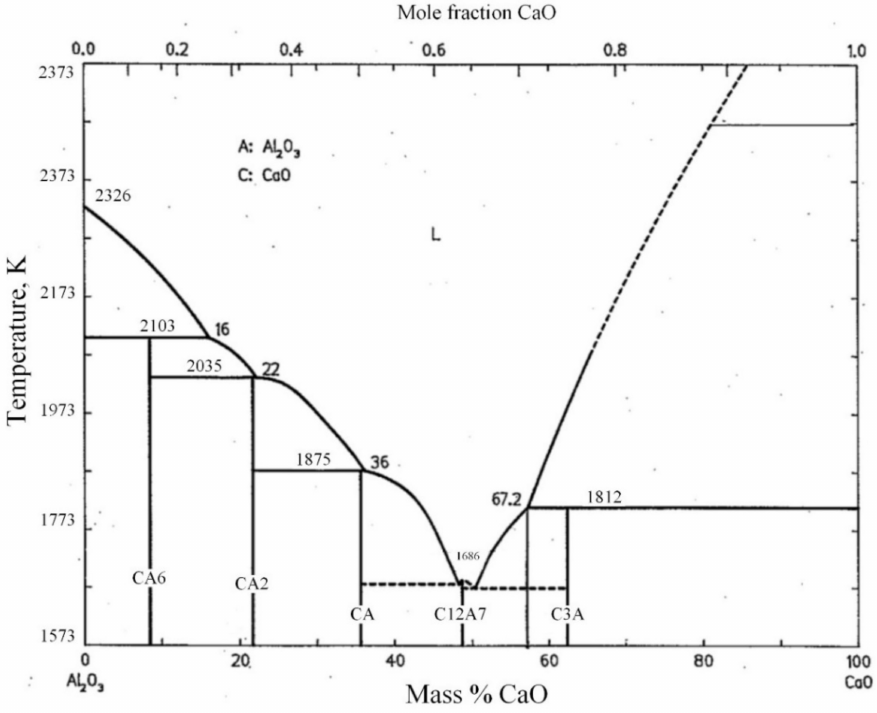
Figure 3. CaO-Al 2 O 3 binary phase diagram, obtained from the slag atlas